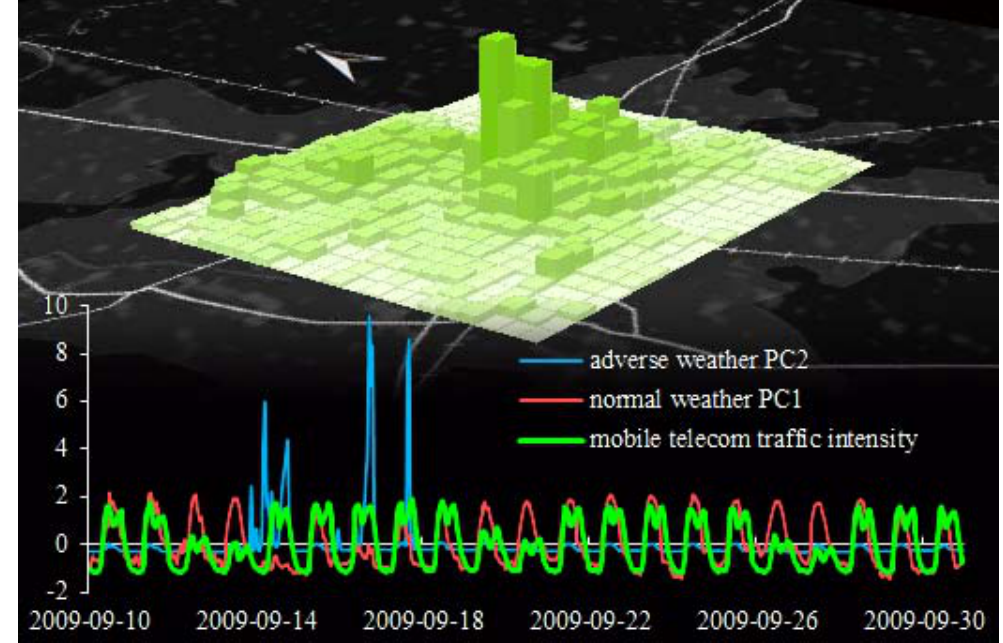
Figure 2. 21 day-time series of total telecom traffic intensity, normal and adverse weather conditions in urban Udine; map: temporally accumulated telecom traffic intensity per 250 m